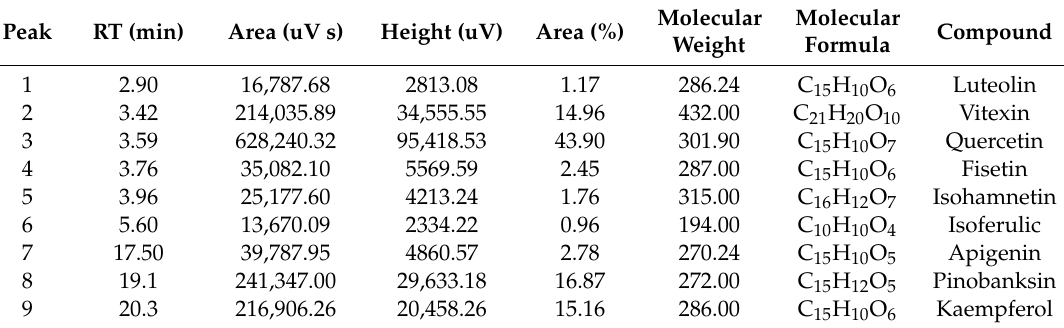
Table 1. Identification of the honeycomb waste extracts using liquid chromatography-mass spectrometry (LC-MS).